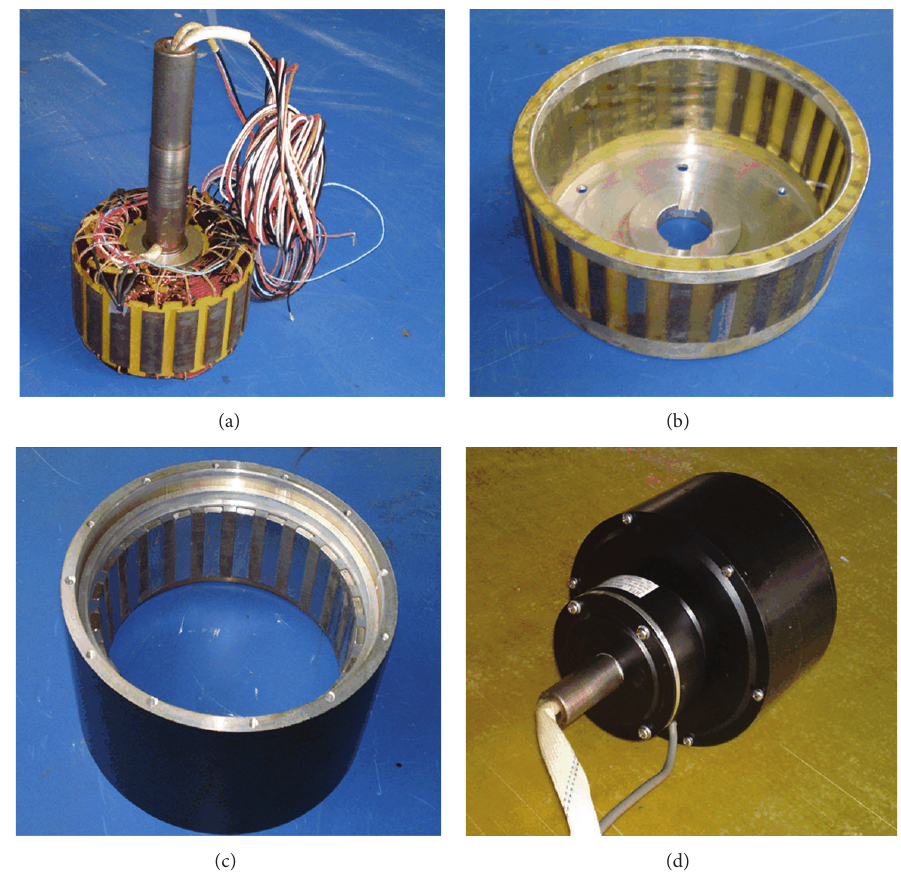
Figure 5: Proposed self-decelerating PM motor: (a) stator, (b) stationary ring, (c) outer-rotor, and (d) assembled